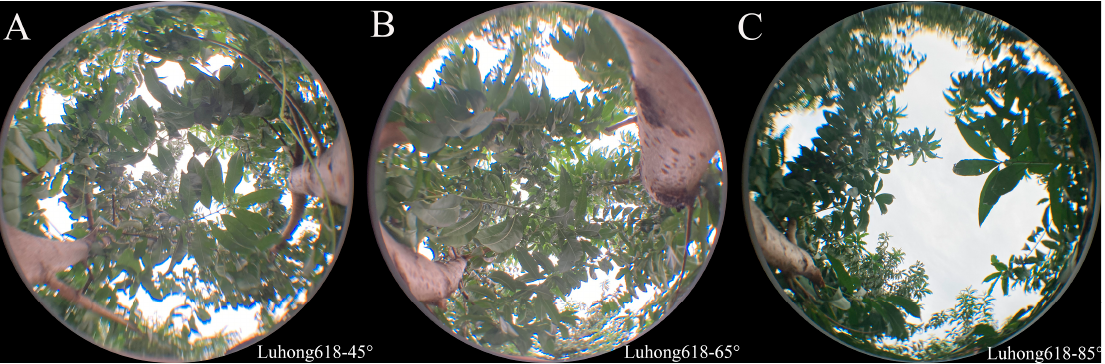
Figure 3. Fish-eye photos of the canopy under di ff erent main branch opening angles (( A ): 45°; ( B ): 65°; ( C ): 85°).